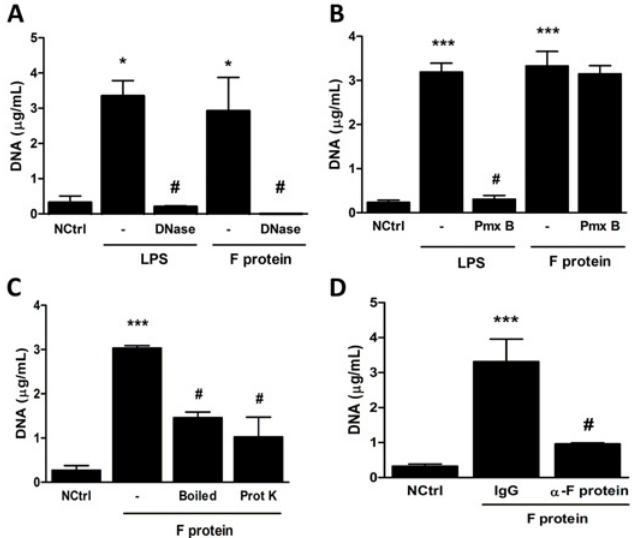
Fig 2. Effect of different treatments on F protein-induced NETs generation. Human neutrophils (2 x 10 6 / mL) were stimulated with: (A) F protein (1 μ g/mL) or LPS (100 ng/mL) in the presence or absence of DNase-1 (100U/mL); (B) F protein (1 μ g/mL) or LPS (100 ng/mL) in the presence or absence of polymyxin B (Pmx B, 1 μ g/mL); (C) F protein (1 μ g/mL), boiled F protein (1 μ g/mL, 10 min at 100°C) or F protein (1 μ g/mL) treated with proteinase K (1 mg/mL for 90 min) for 3 h at 37°C with 5% CO 2 . (D) F protein solution was treated with monoclonal anti-F protein (10 μ g/mL) or isotype-matched (10 μ g/mL) antibody and neutrophils (2 x 10 6 /mL) were stimulated with these preparations for 3 h at 37°C with 5% CO 2 . NETs were quantified in culture supernatants using Quant-iT dsDNA HS kit. Data are representative of at least 2 independent experiments performed in triplicates and represent mean ± SEM. * p < 0.05; *** p < 0.001 when compared to negative control (NCtrl); #p < 0.05 when compared to LPS- or F protein-treated cells.